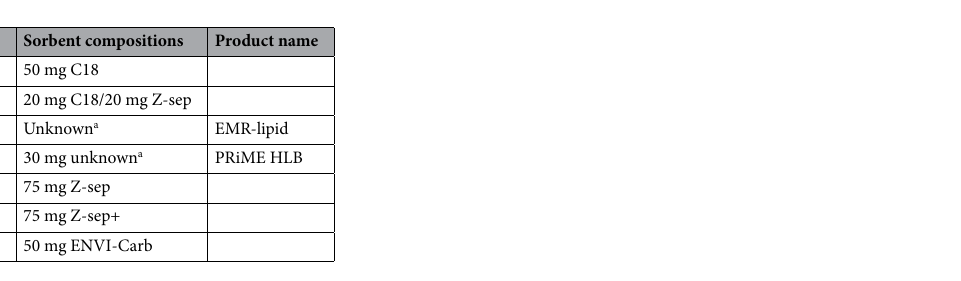
Table 1. The list of clean-up procedures investigated in this study. PRiME HLB hydrophilic-lipophilic balance. a Contents are not disclosed by the producer; EMR-lipid: enhanced matrix removal-lipid method.